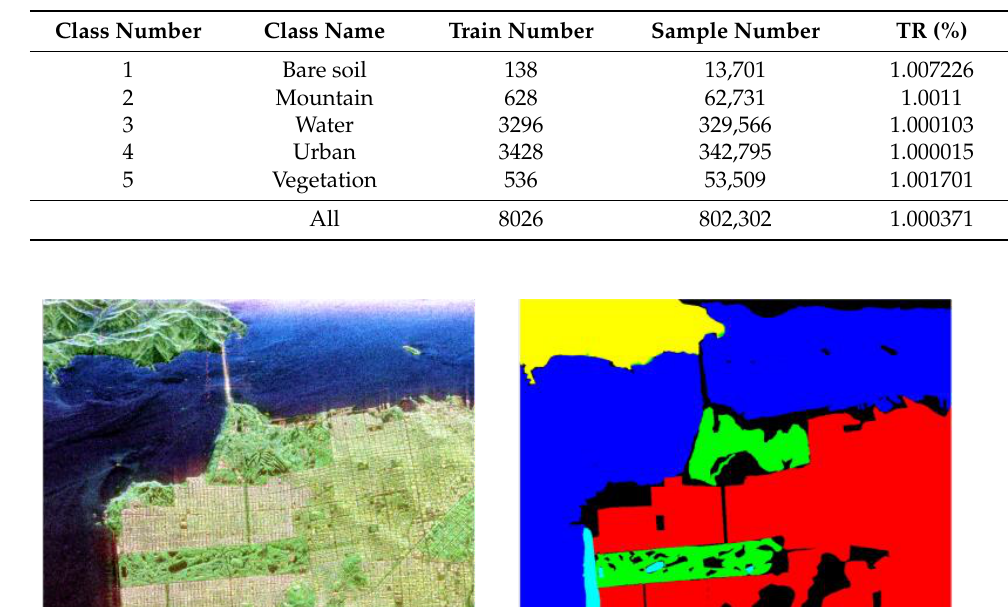
Table 2. Details of classes and training samples for AIRSAR San Francisco data (TR represents training ratio).